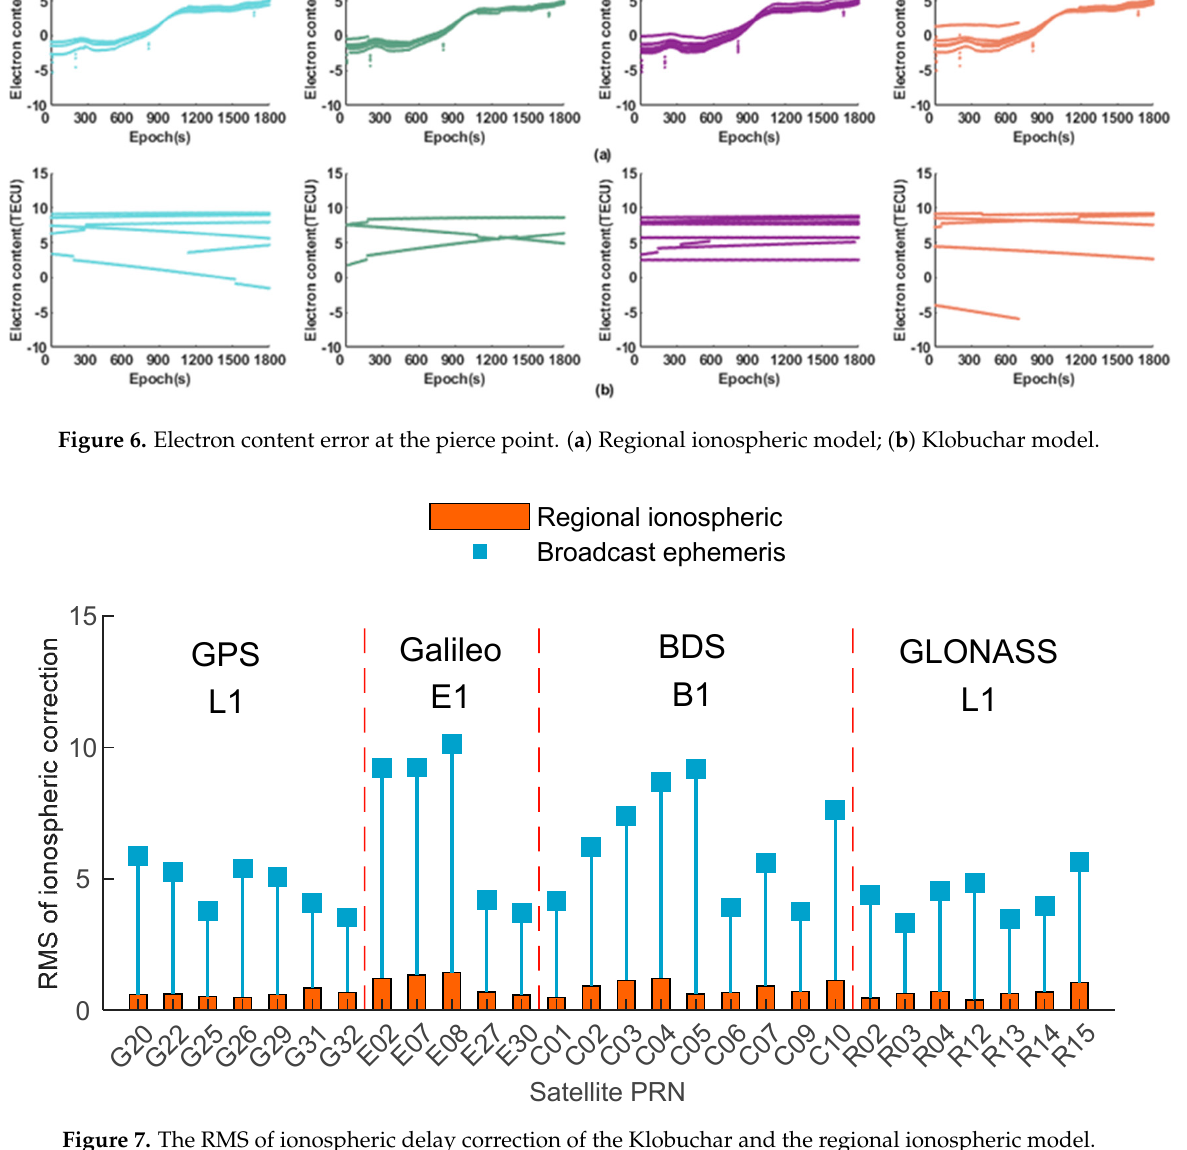
Figure 6. Electron content error at the pierce point. ( a ) Regional ionospheric model; ( b ) Klobuchar model.